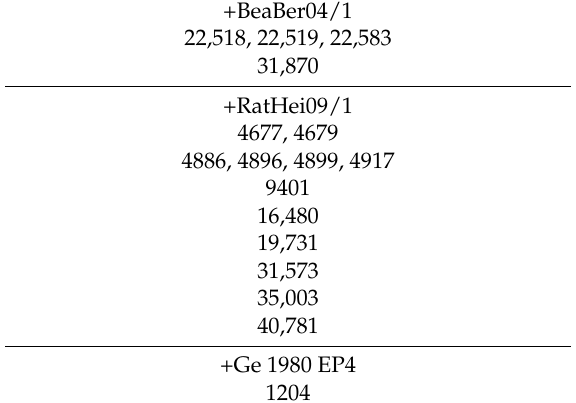
Figure 4. The contrast of unique SNPs found in the genomic core of 10 cowpox viruses (using the BBB Find Differences feature) with that of a maximum-likelihood phylogenetic tree. Red numbers denote the number of unique SNPs found for the virus that are not shared with any of the others. The phylogenetic tree branch scale denotes the average number of nucleotide substitution per site. Table 1. SNPs shared by CPXV-BR, CPXV-Nor1994MAN, and strain noted in the table; all other viruses in Figure 4 have a different nucleotide. SNPs close together are grouped on a single line in the table.